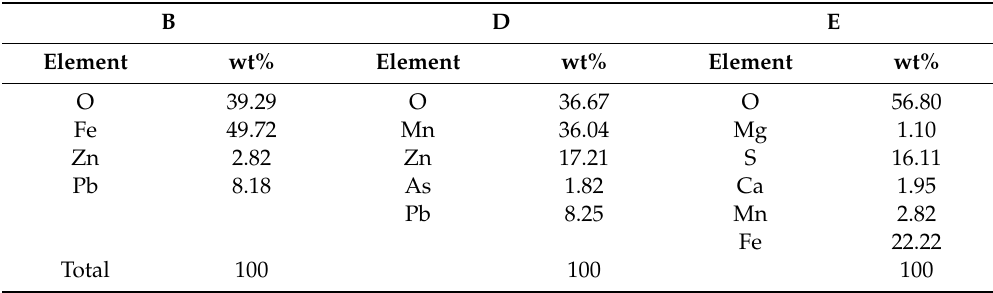
Figure 2. X-ray diffraction patterns of the representative weathered tailings samples with a cobalt target, where the A, C, F, G, Gs, J, K, M and T peaks represent amphibole, chlorite, feldspar, goethite, gypsum, johansennite, kaolinite, mica and talc, respectively. Table 2. Chemical compositions of the samples collected from point 1-3 and 2 analyzed via EDS at each point shown in Figure 3.